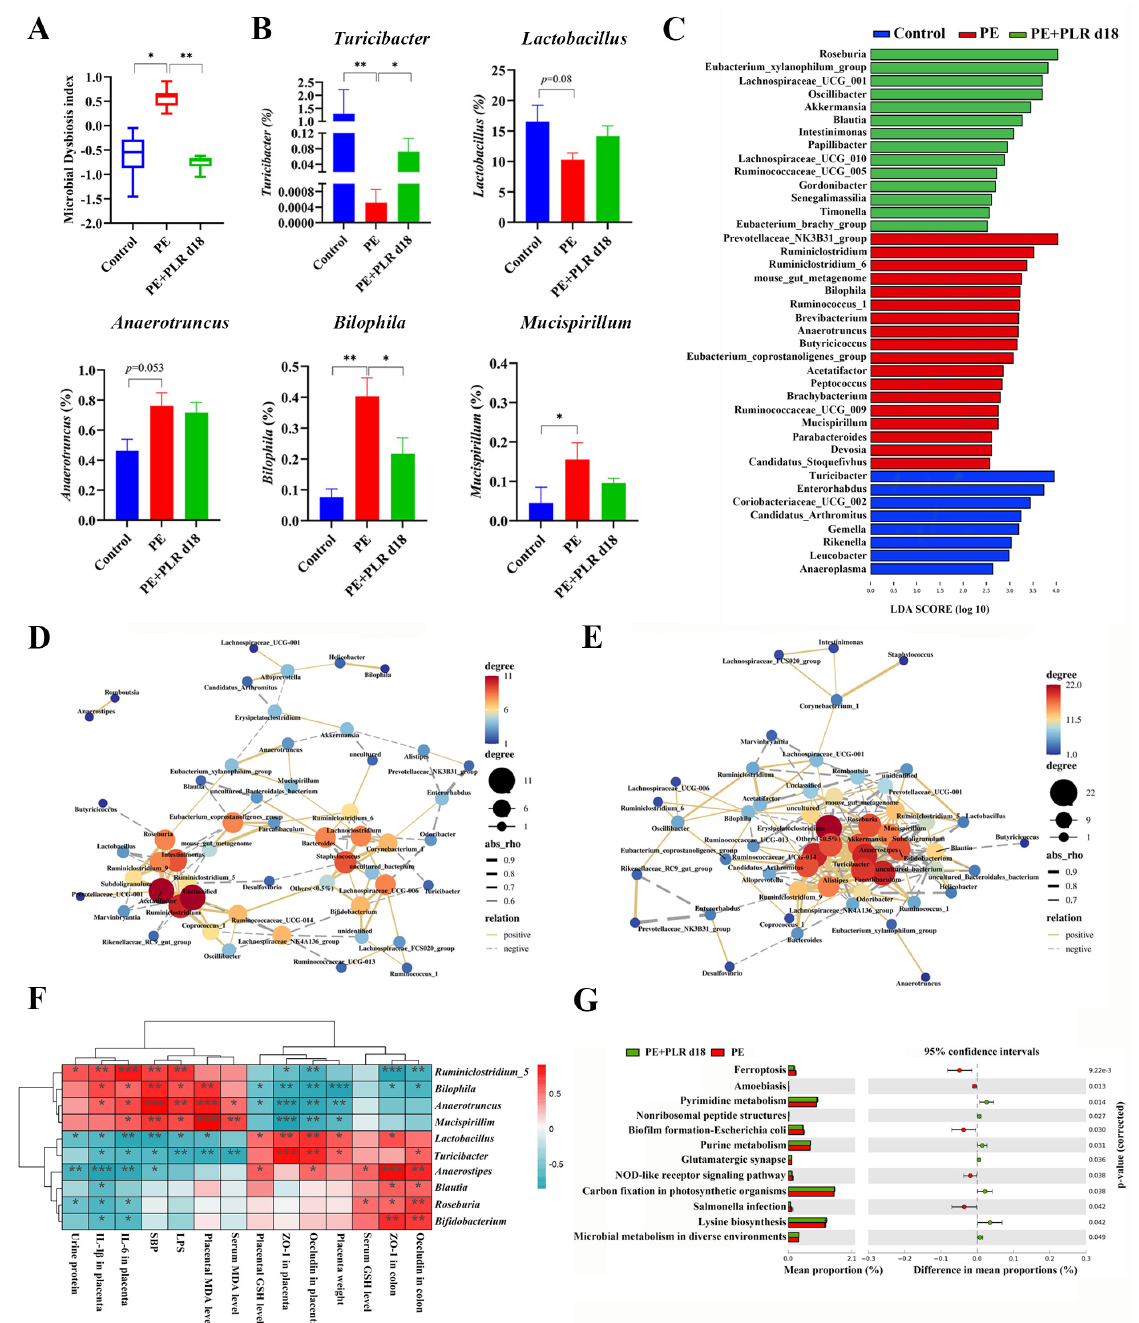
Figure 7. PLR corrected intestinal dysbacteriosis in PE mice. ( A ) Microbial Dysbiosis index for each group. ( B ) Comparison of the gut microbiota of mice among the three groups by Turicibacter , Lacto- bacillus , Anaerotruncus , Bilophila , and Mucispirillum . ( C ) Biomarkers at the genus level for each group screened based on LDA score. Different colors represent different groups. ( D , E ) Correlation network of gut microbiota in the PE and PE+PLR d18 groups. ( F ) Correlation heatmap of differentially abundant microbial genera and representative indicators. Correlations were determined by calculating Spearman’s correlation coefficient. ( G ) Pathways that were predicted to show significantly different abundances between the PE group and the PE+PLR d18 group according to the Kyoto Encyclopedia of Genes and Genome (KEGG) pathway analysis. In this figure, n = 7–12 for each group. Data are expressed as the mean ± SEM. * p < 0.05, ** p < 0.01, *** p < 0.001 (Kruskal–Wallis test).